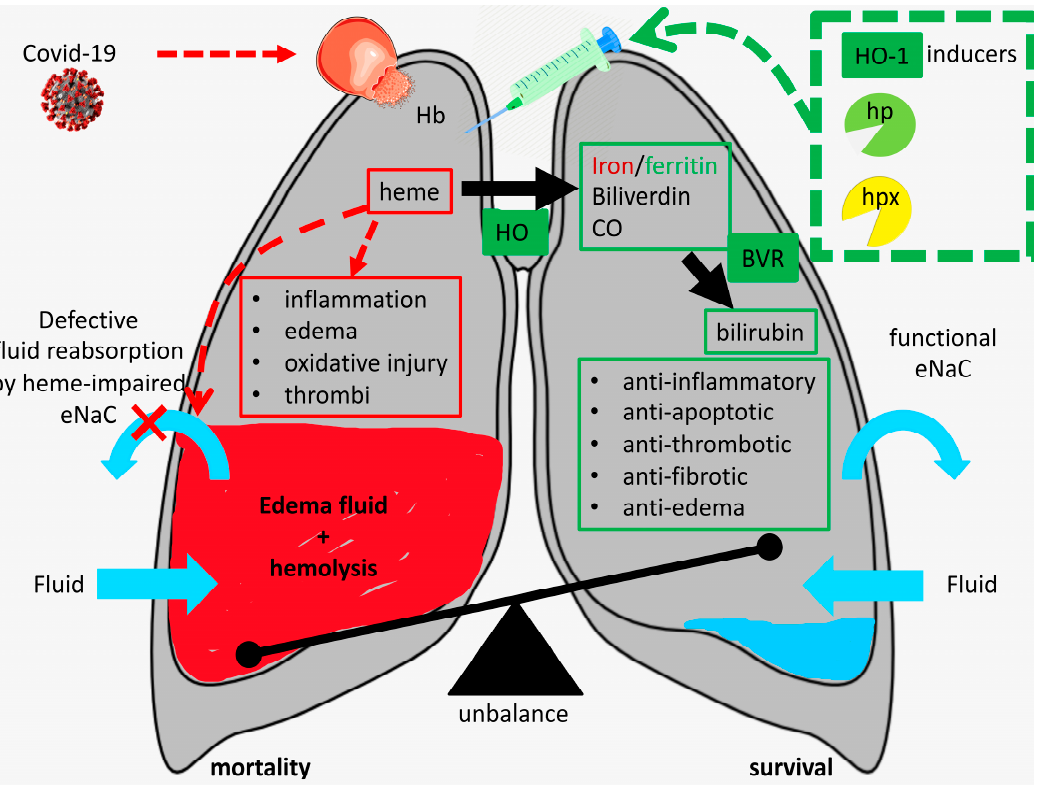
Figure 1. Heme-induced pulmonary complications following SARS-CoV-2 infection. Strategies to harness hemolysis-derived alveolar heme include administration of inducers of heme oxygenase (HO)-1 and hemoglobin (Hb)/heme scavengers (see green dashed box). “Proof of principle” studies should be performed to assess whether targeting heme by induction of HO-1 or administration of scavengers haptoglobin (hp)/hemopexin (hpx) can indeed attenuate or prevent complications in critically ill COVID-19 patients (see text for details).